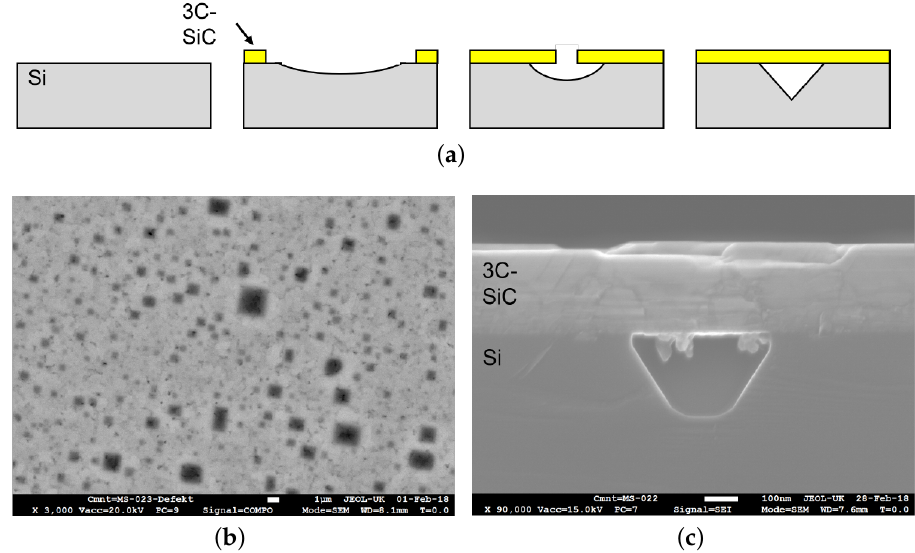
Figure 9. ( a ) Scheme of the formation of voids at the 3C-SiC/Si interface. ( b ) Top view scanning electron microscopy (SEM) image of a 3C on Si sample grown at 1200 °C. The darker areas are attributed to voids underneath the 3C-SiC layer. ( c ) Crosscut SEM image of a void at the Interface